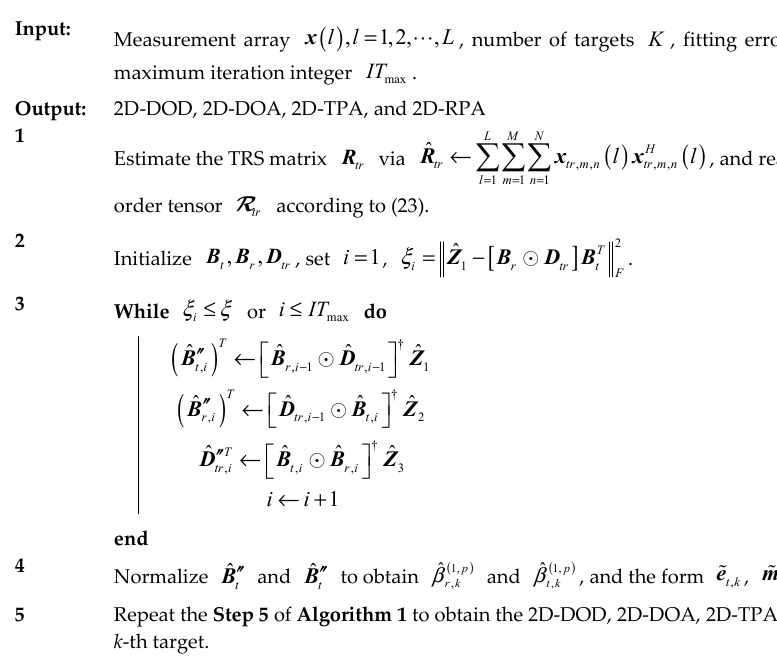
Algorithm 3: Algorithmic steps of the T-TRS approach Algorithm 3: algorithmic steps of the T-TRS